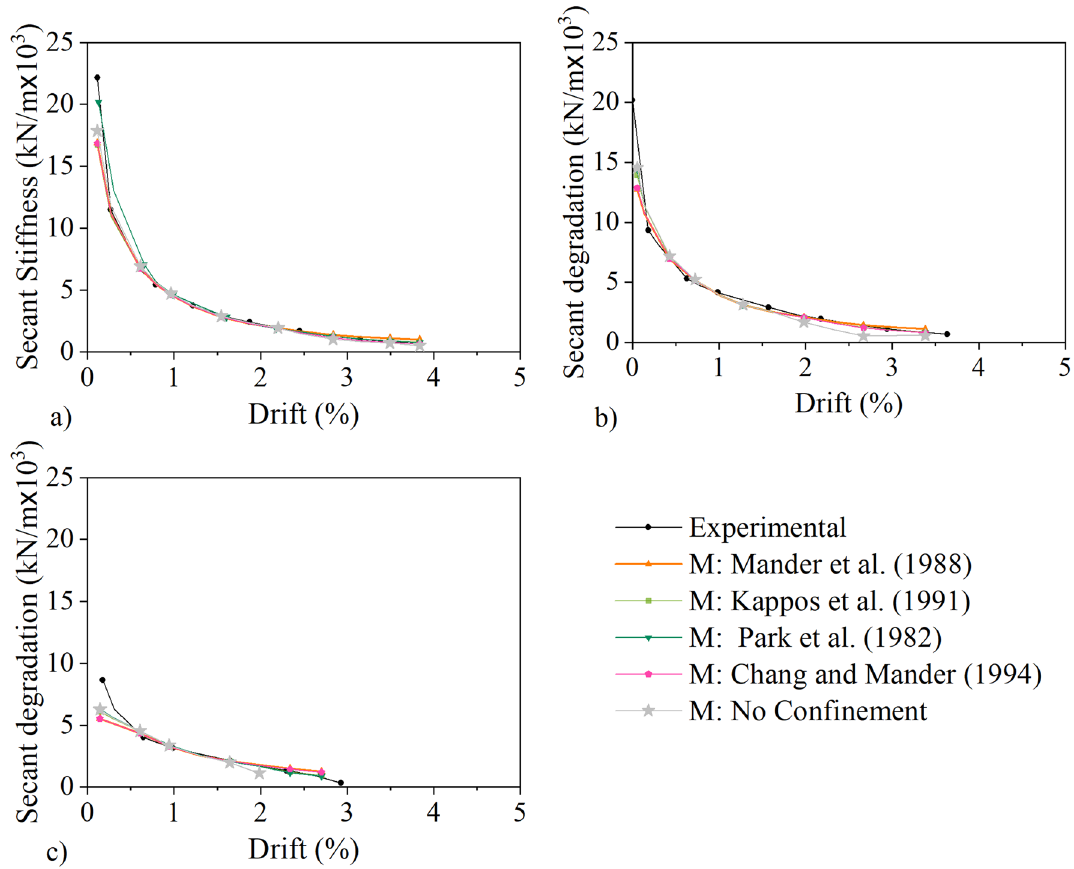
Figure 12. Secant Stiffness: ( a ) column C, ( b ) column M, ( c ) column